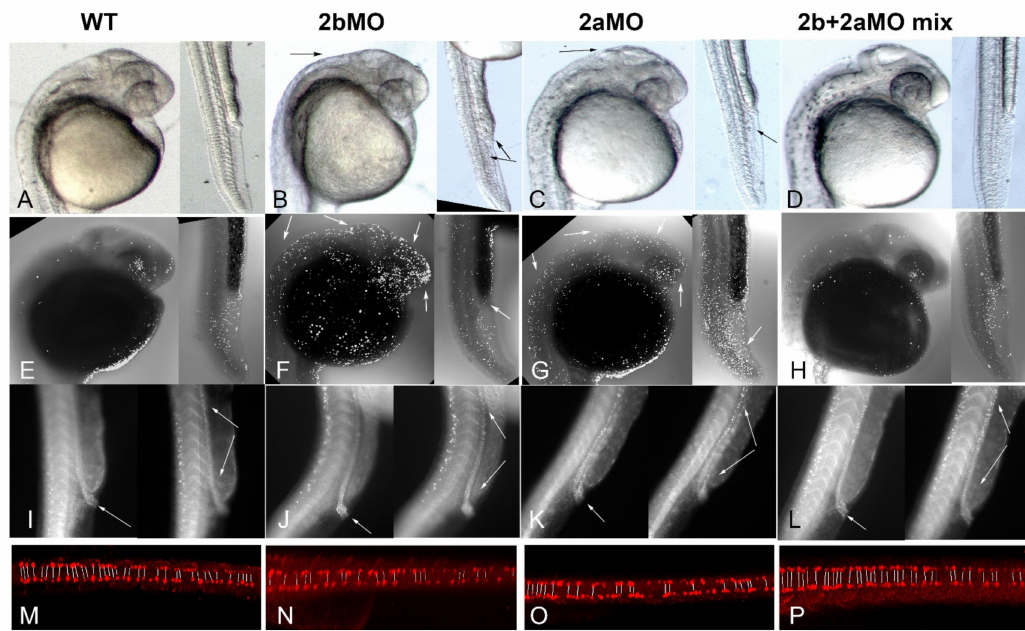
Figure 7. Co-knockdown of Brd2a and Brd2b suppresses morphant defects in both brain and pronephros of morphant embryos at 24 hpf. Double knockdown was used to test for genetic interaction between paralogs. Panels ( A – D ): Bright- field images of head and trunk of representative 24 hpf prim5 embryos from indicated treatment groups assessed for morphology: ( A ) uninjected, ( B ) brd2b MO-injected, ( C ) brd2a MO-injected, and ( D ) brd2b MO + brd2a MO co-injected. Panels ( E – H ): Darkfield images of representative embryos from the same treatment groups assessed by TUNEL assay for apoptotic nuclei: ( E ) uninjected, ( F ) brd2b MO-injected, ( G ) brd2a MO-injected, and ( H ) brd2b MO + brd2a MO co-injected. Co-injection of MOs from each paralog suppresses morphant defects in both morphology and cell death in the brain and trunk, indicating genetic interaction with functional antagonism between paralogs. Black arrows indicate reduced brain, ill-formed MHB region, disorganized PBI common to both morphants ( B , C ), and plug of excess cells at the cloaca unique to brd2b MO morphants (upper arrow in B, trunk). White arrows show increased apoptosis in brain and PBI common to both morphants ( F , G , head; G , trunk), while lack of apoptosis is seen at the cloaca only in brd2b MO morphants ( F , trunk). See Table 1 for population morphology data and Figure 5 for quantitative TUNEL data. Panels ( I – L ): Darkfield images of pronephric duct in trunks of representative 24 hpf prim 5 embryos from the indicated treatment groups assessed for Pax2a(+) cells by immunofluorescence : ( I ) uninjected, ( J ) brd2b MO-injected, ( K ) brd2a MO-injected, and ( L ) brd2b MO + brd2a MO co-injected. Cloacal opening is indicated by white arrow in left panels. Distribution along the ductal tube of Pax2a(+) pronephric precursor cells is highlighted between white arrows in right panels. Co-knockdown suppresses morphant defects of each paralog, bringing distribution of cells along the duct and at the cloaca closer to wildtype. (see also Figure 6O,P,Q). Panels ( M – P ): Darkfield images of spinal interneurons along dorsal trunks of representative 24 hpf embryos from the indicated treatments groups assessed for Pax2a(+) cells by immunofluorescence: ( M ) uninjected, ( N ) brd2b MO-injected, ( O ) brd2a MO-injected, and ( P ) brd2b MO + brd2a MO co-injected. Co-knockdown suppresses the morphant mis-pairing defect of each paralog, and restores interneuron number and pairing to near wildtype levels. Lines connect symmetrically paired neurons; unpaired neurons appear solo on one or the other side of the central nerve